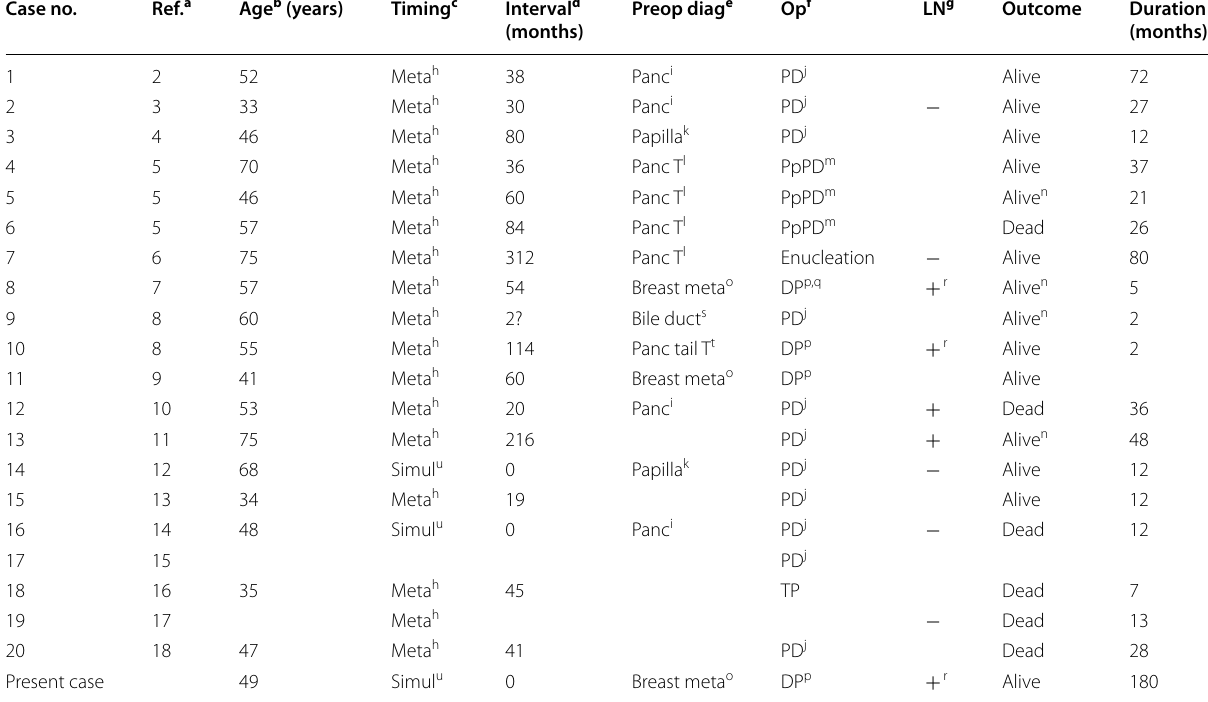
Table 1 Reported cases undergoing pancreatic metastasis resection from breast